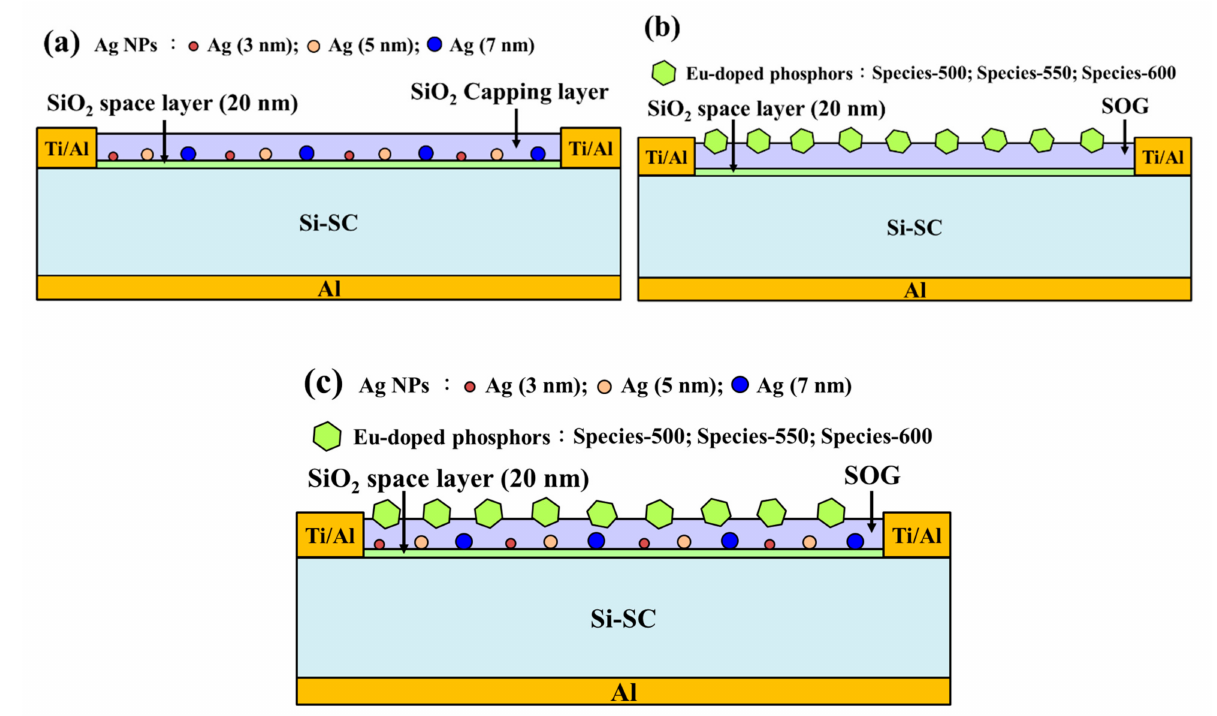
Figure 1. Schematic diagrams showing cells with ( a ) plasmonic Ag-NP layer, ( b ) SOG:Eu-doped phosphor layer, and ( c ) metal-enhanced fluorescence layer of Ag-NPs/SOG:Eu-doped